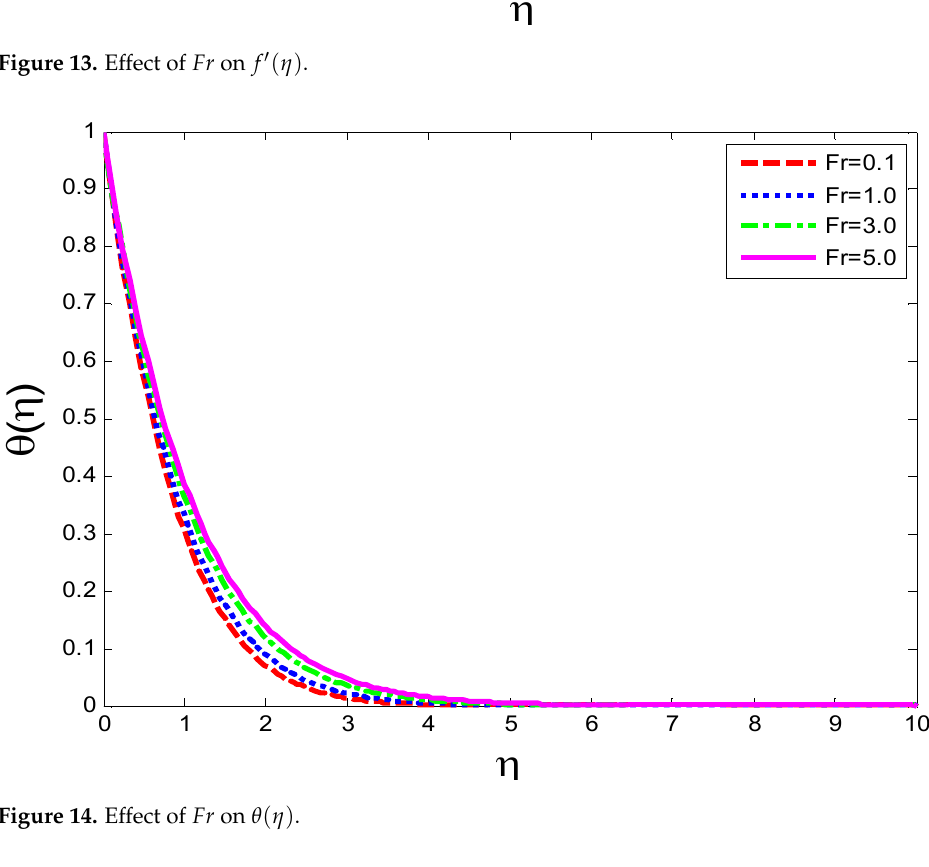
Figure 14. Effect of Fr on θ ( η )